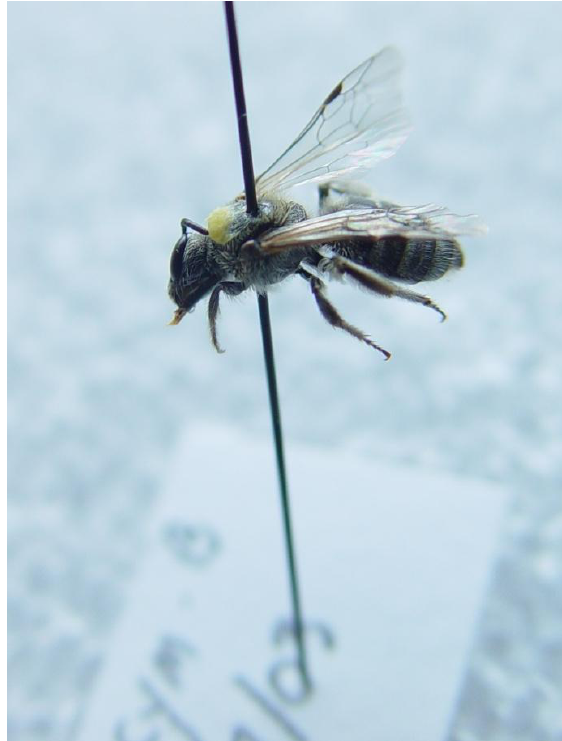
Figure 4. Pinned specimen of Lasioglossum sp (collected in 2003) wearing the entire contents of an anther cell on the dorsum of its thorax (Photograph by Andrew